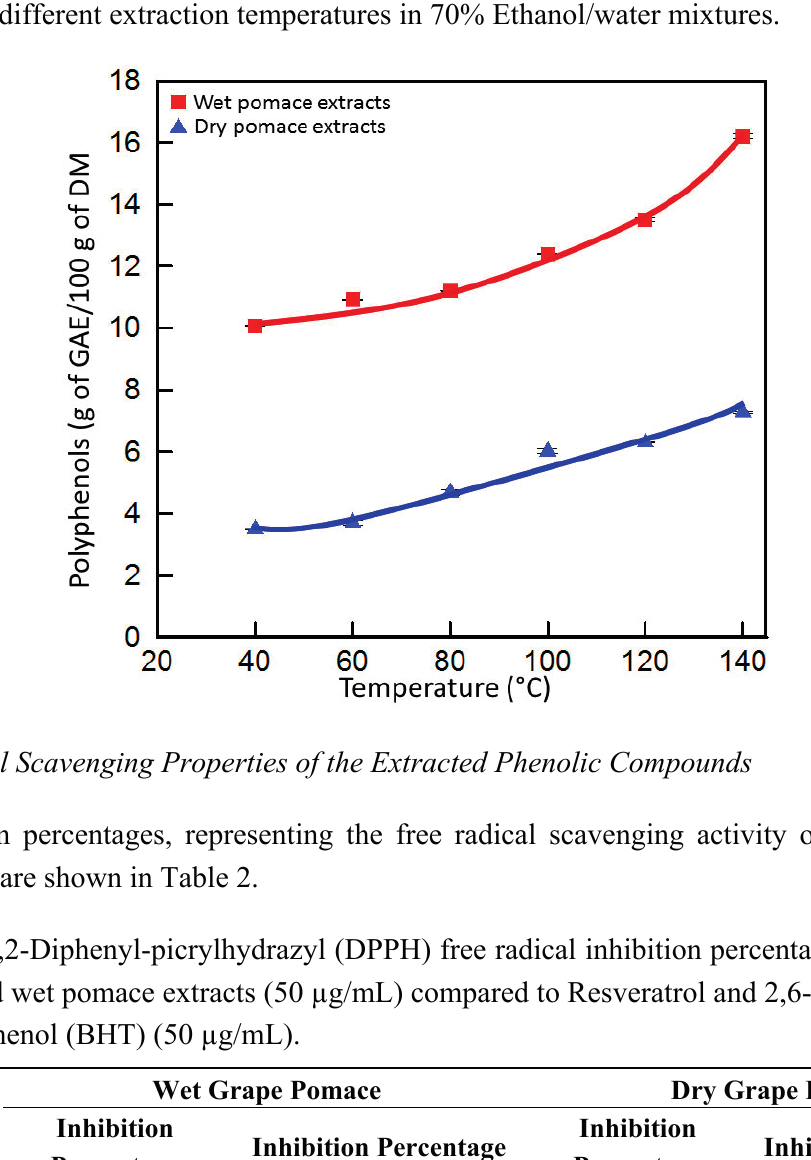
Figure 4. Phenolic compounds content (g of GAE/100 g of DM) of wet and dry pomace extracts at different extraction temperatures in 70% Ethanol/water mixtures.